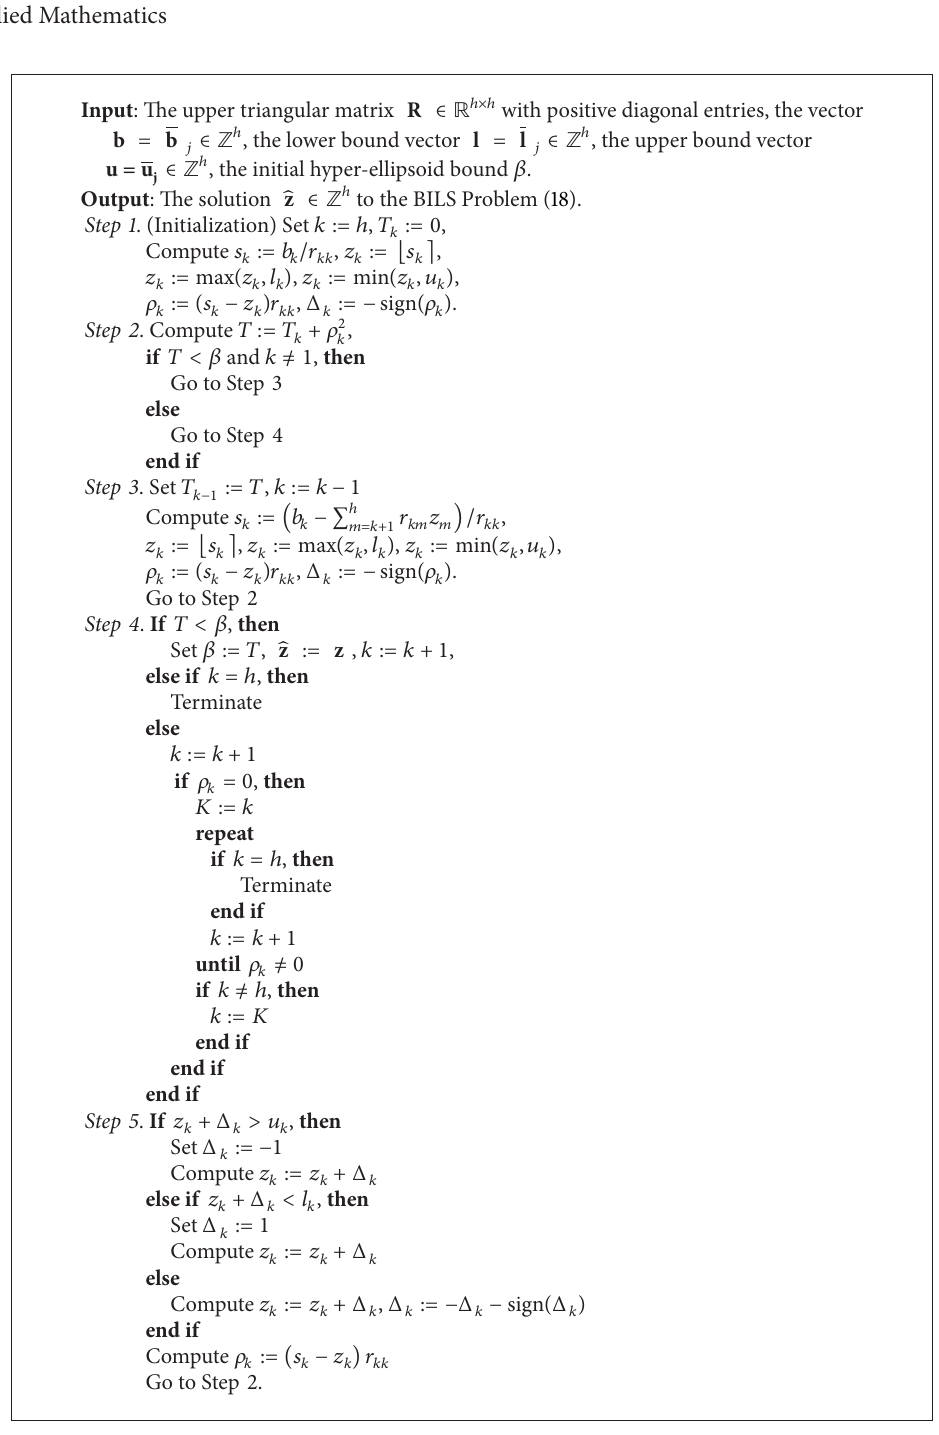
Algorithm 1: Crosstalk reduction